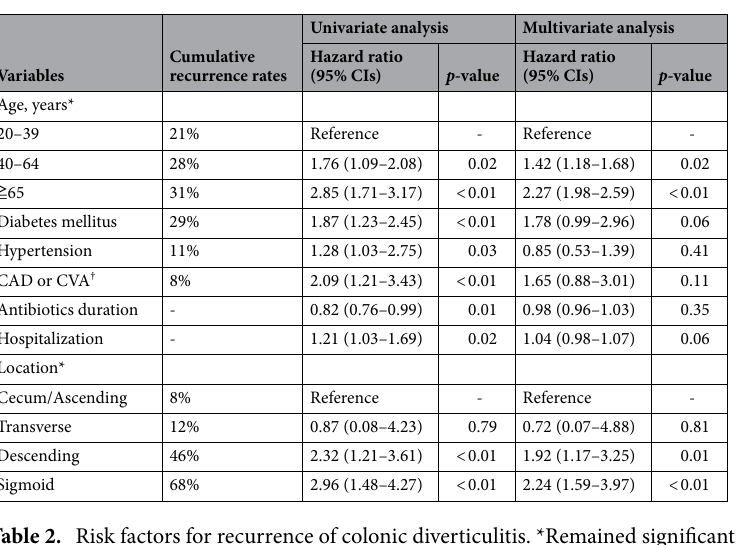
Table 2. Risk factors for recurrence of colonic diverticulitis. *Remained significant after adjusting other confounders. † CAD, coronary artery disease; CVA, cerebrovascular accident.